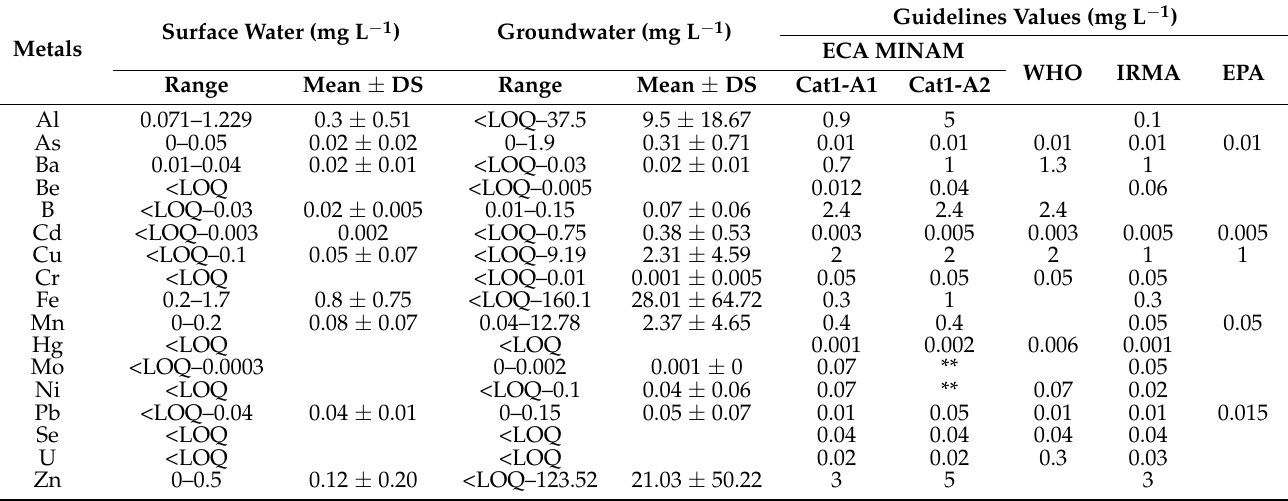
Table 1. The concentration of heavy metals in the water systems belonging to the study area and reference